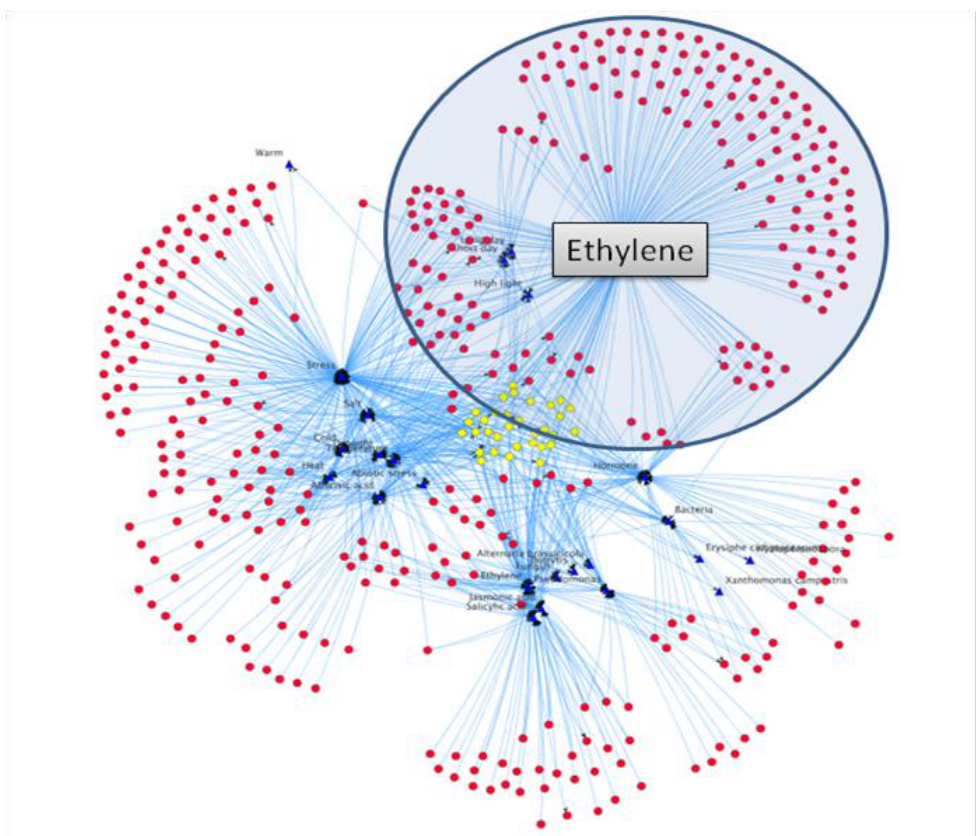
Figure 6: An example protein-stress association network based on 5 or more co-citations. The network contains 444 proteins (red circles), 25 stresses (blue triangles) and 1133 relations (blue edges). Proteins in the centre of the network (yellow circles) are implicated in several plant stress responses. The Ethylene association sub-network is